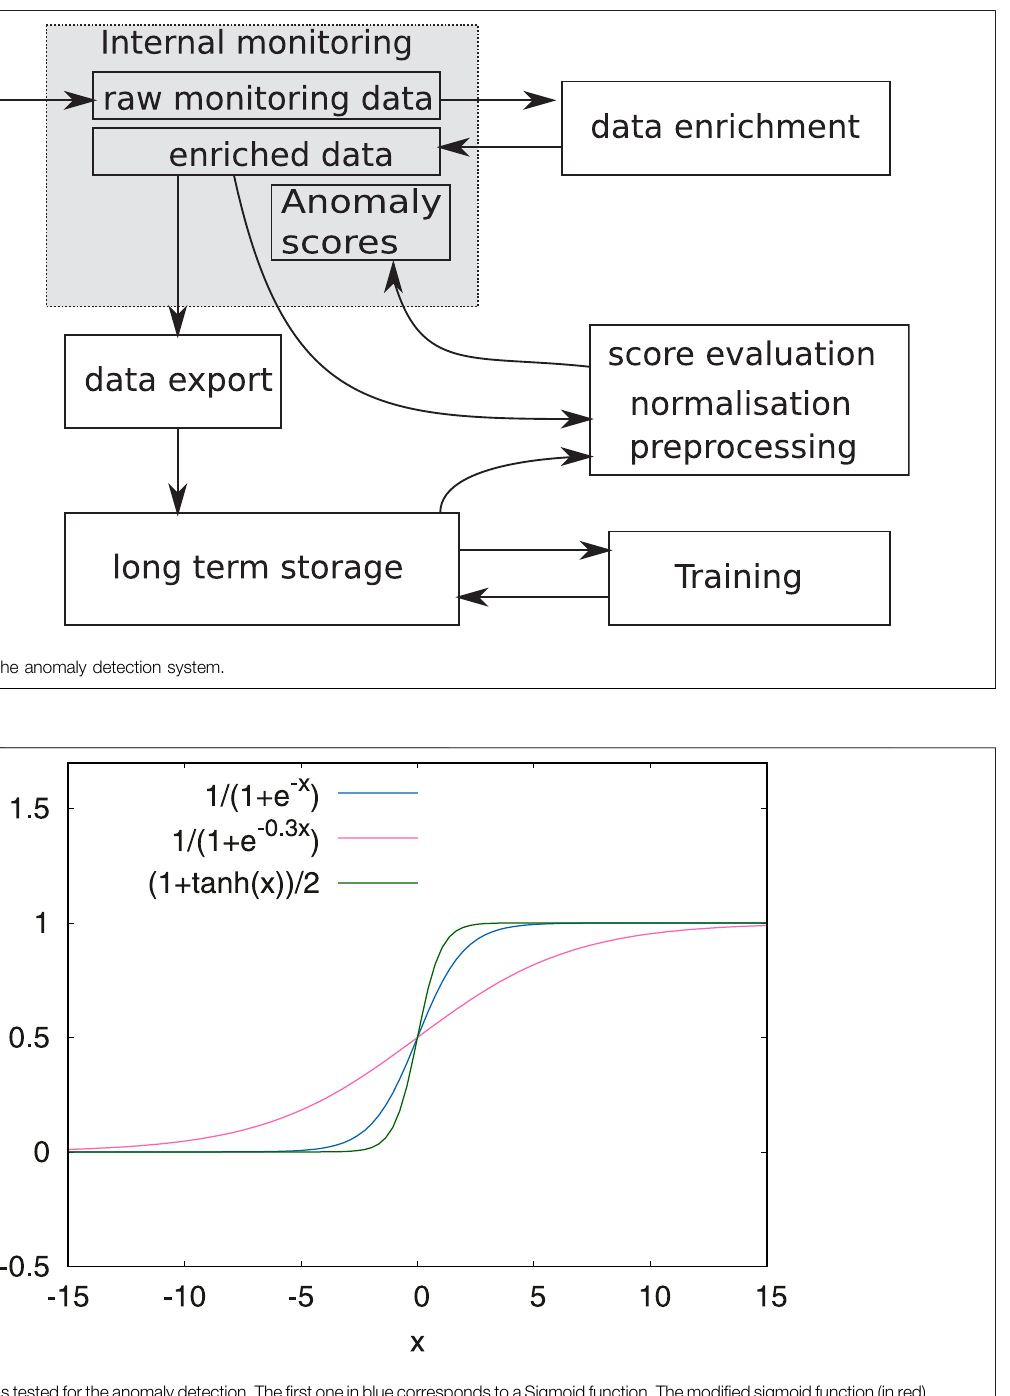
Frontiers in Big Data |